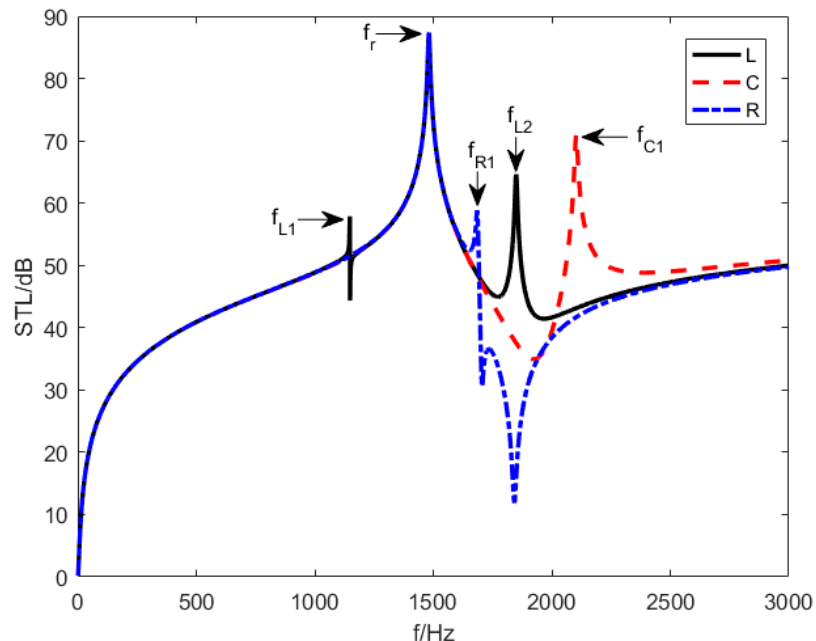
Figure 14. The STL curves under different shunting circuits.